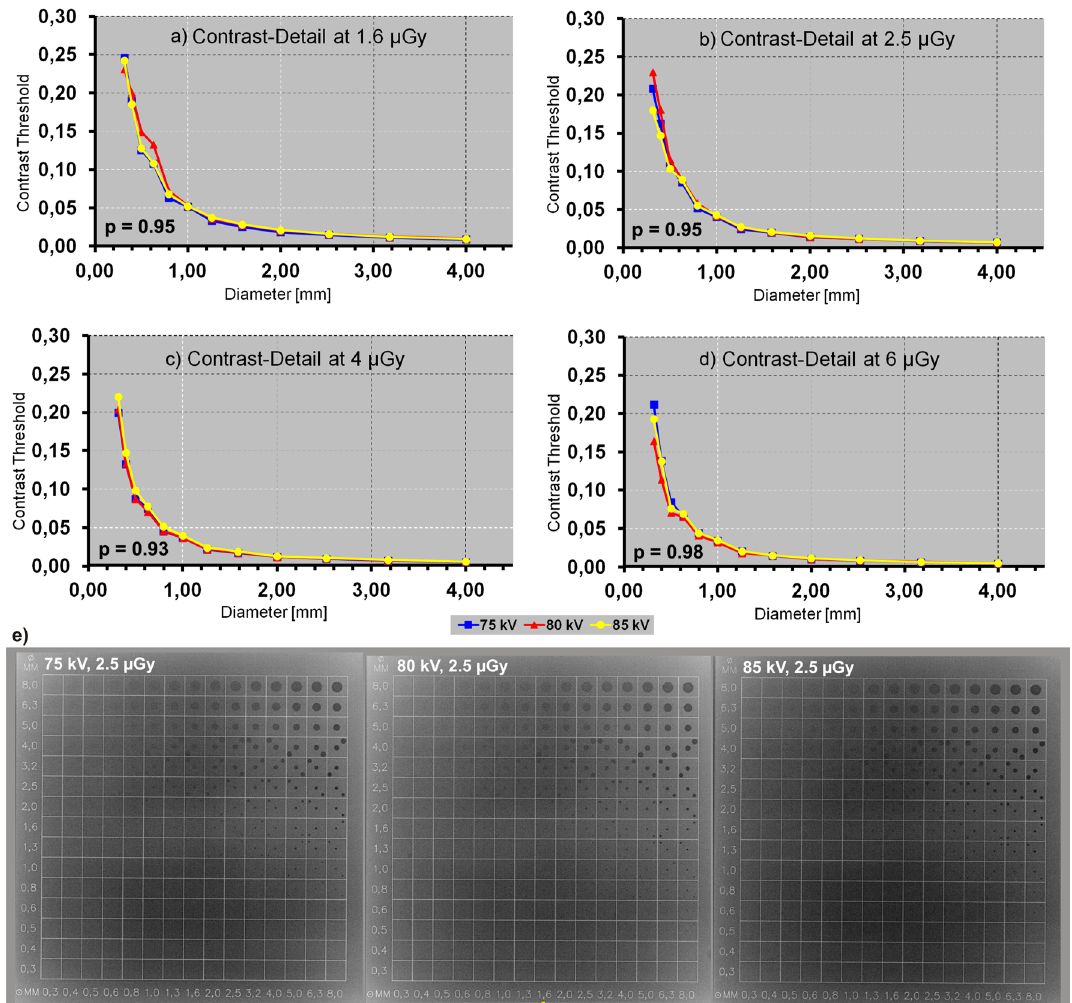
Figure 1. Phantom study: Low-contrast performance is not dependent on kV-setting in big proximal extremity examination simulation. Contrast-detail-curves (CDC) decrease with increasing low-contrast-structure (LCS) diameter. Threshold values for 5, 6.3 and 8 mm asymptotically approximate 0 (data hidden). ( a ) At an exposure dose of 1.6 µGy, no significant difference was found between the CDC of different kV-settings (p = 0.95). ( b ) At an exposure dose of 2.5 µGy, no significant difference was found between the CDC of different kV-settings (p = 0.95). ( c ) At an exposure dose of 4 µGy, no significant difference was found between the CDC of different kV-settings (p = 0.93). ( d ) At an exposure dose of 6 µGy, no significant difference was found between the CDC of different kV-settings (p = 0.98). ( e ) Example images of CDRAD 2.0 at 2.5 µGy at 75, 80 and 85 kV (from left to right). Reprinted from S. Notohamiprodjo et al. “Dependency of Low-Contrast Detail on Exposure Dose and Tube Voltage in Digital Flat-Panel Detector Radiography – a pre-clinical phantom study” Biomedical physics & engineering express 2018, 4(2) 10 (c) IOP Publishing. Reproduced with permission. All rights